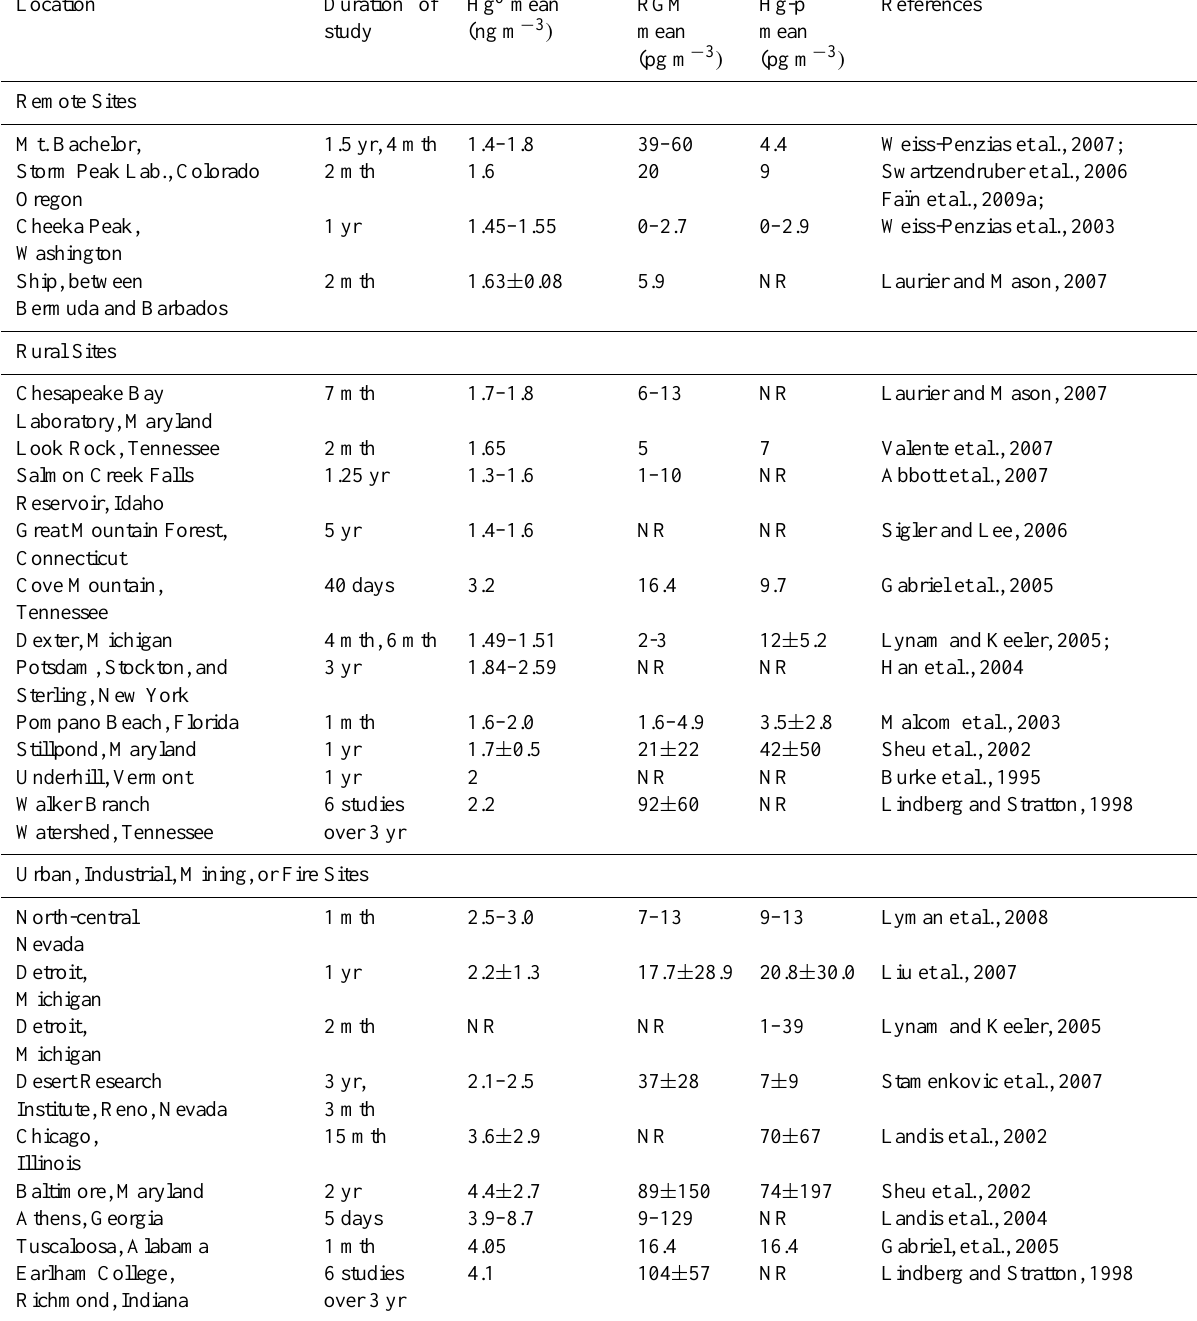
Table 5. Summary of Hg 0 , RGM and Hg-p measurements made at remote, rural and urban locations in the United States. NR: “not reported”.